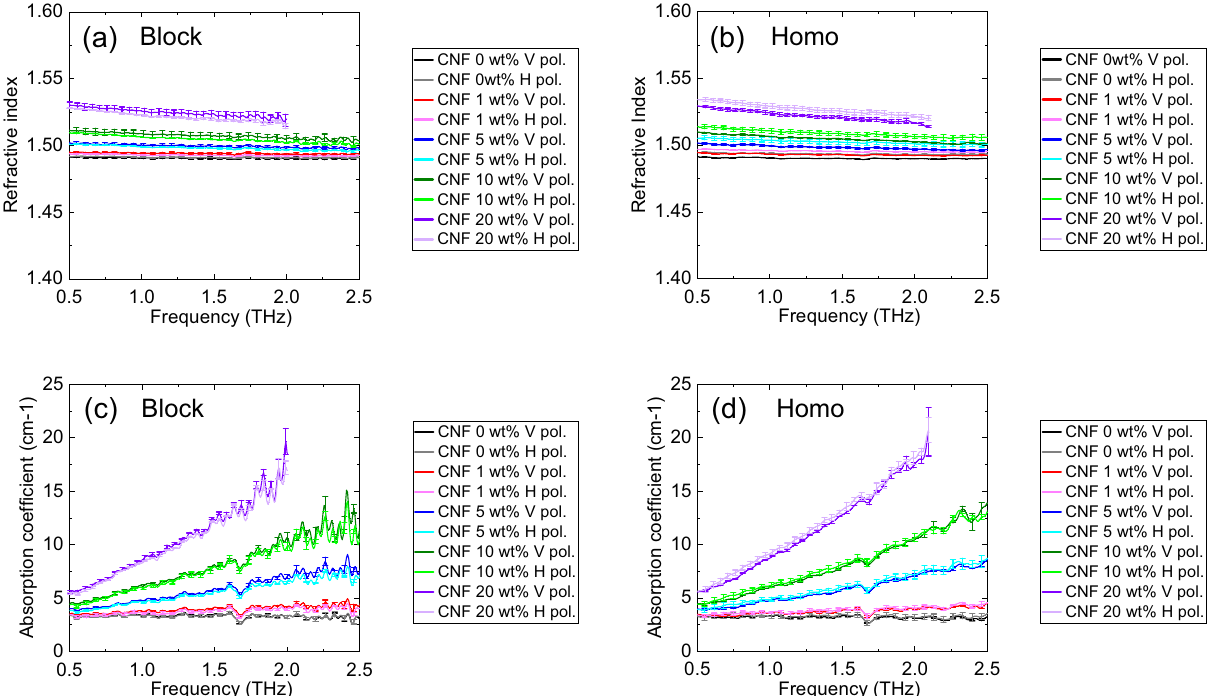
Figure 6. Optical properties of several PP/CNF composites with different CNF concentrations: ( a ) refractive index of block-PP/CNF, ( b ) refractive index of Homo-PP/CNF, ( c ) absorption coefficient of block-PP/CNF, ( d ) absorption coefficient of